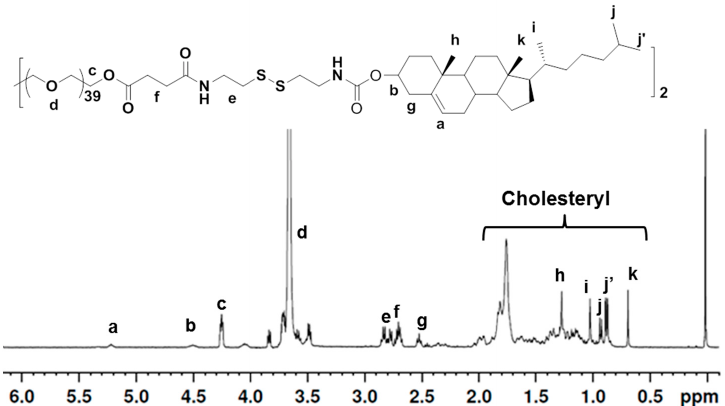
Figure 1. 1 H NMR spectrum of poly(ethylene glycol)-cholesteryl conjugate (Chol-ss-PEG-ss-Chol) measured in CDCl 3 .